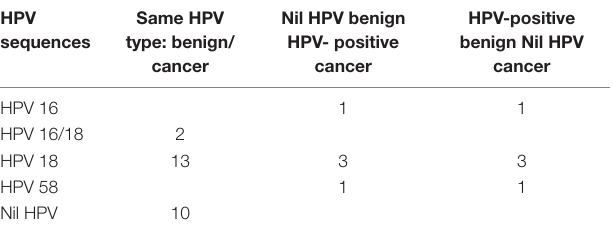
TaBle 2 | high risk hPV sequences in benign breast and subsequent invasive ductal carcinoma (iDc) breast cancer specimens in the same